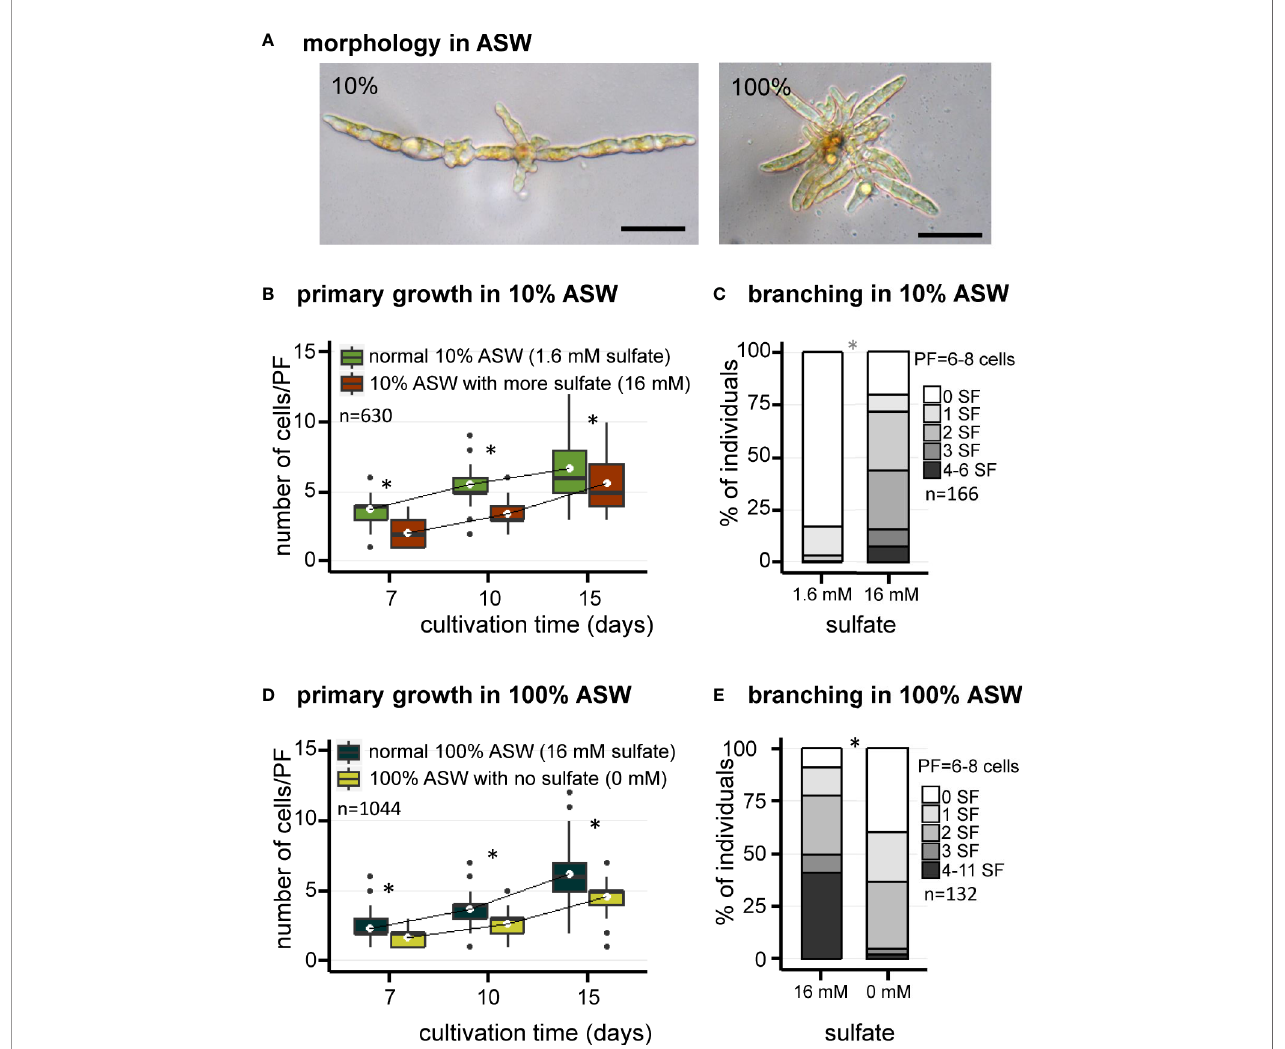
FIGURE 2 | Morphology of E. subulatus grown in arti fi cial seawater (ASW) featuring distinct salinities and sulfate contents. (A) Morphology of E. subulatus parthenosporphytes cultivated for 15 days in ASW featuring different salinities. Scale bar = 50 µm. (B, D) Elongation of E. subulatus primary fi lament (PF) was signi fi cantly greater (Mann-Whitney test: p < 0.001) when the gametes were cultivated in diluted seawater (10%) rather than in undiluted seawater (100%), except at later stages of development. (C, E) The branching activity of E. subulatus was signi fi cantly greater (Mann-Whitney test: p < 0.001) when the gametes were cultivated in undiluted seawater (100%) rather than in diluted seawater (10%). (B) Elongation of E. subulatus primary fi lament (PF) was not increased when the 10% ASW medium (containing 1.6 mM sulfate) was complemented with additional sulfate (i.e., up to 16 mM, the concentration found in 100% ASW) but, instead, was signi fi cantly reduced (Mann-Whitney test: p < 0.001). (C) The branching activity of E. subulatus signi fi cantly increased (Mann-Whitney test: p < 0.001) when the gametes were cultivated in a 10% ASW medium featuring a greater sulfate concentration. (D) Elongation of E. subulatus primary fi lament (PF) was signi fi cantly reduced (Mann-Whitney test: p < 0.001) when the gametes were cultivated in ASW 100% without sulfate. (E) The branching activity of E. subulatus was signi fi cantly reduced (Mann-Whitney test: p < 0.001) when the gametes were cultivated in a sulfate-depleted medium. To prevent a deleterious effect of sulfate starvation on protein synthesis, methionine was used as replacement of exogeneous sulfate when depleted. * above bars indicates signi fi cant